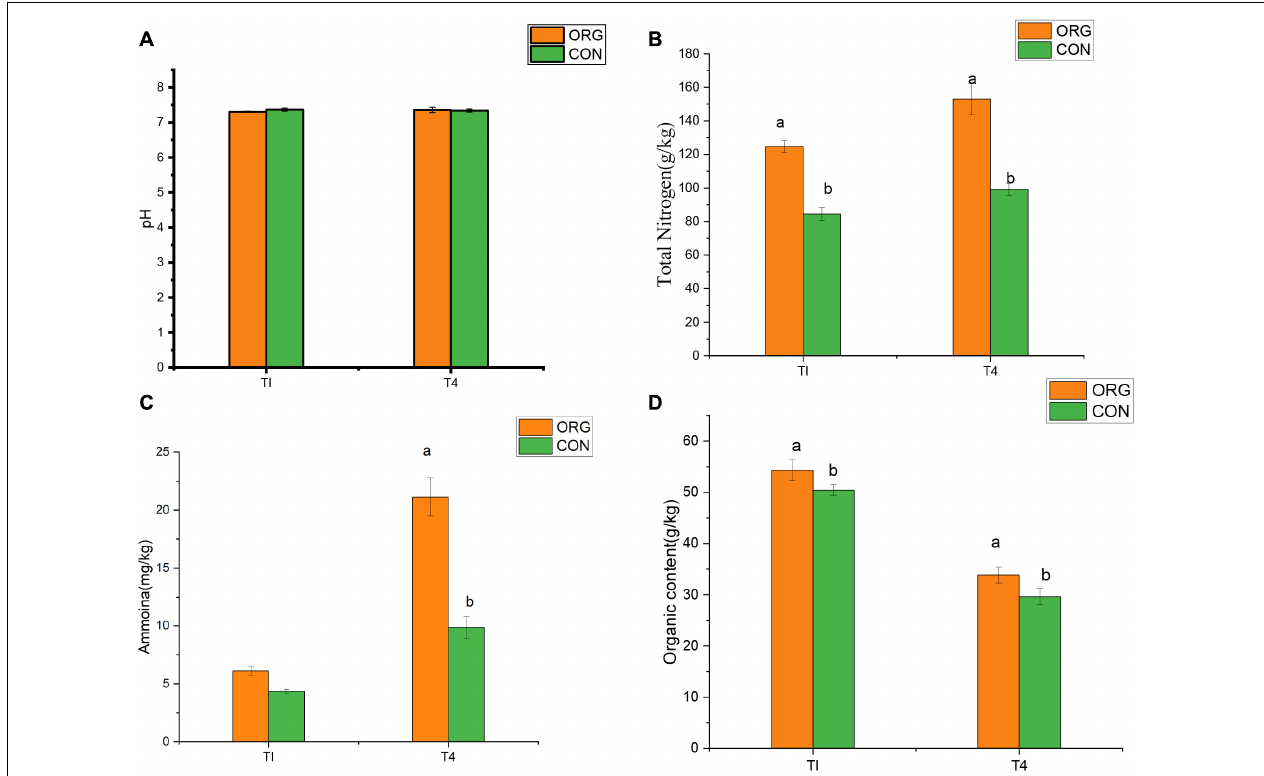
FIGURE 1 | Discrimination of physiochemical soil properties during the field experiment. (A–D) Differences in major physiochemical soil properties between seedling phase and fruiting phase (averaged over time). (A) pH, (B) total nitrogen, (C) ammonia content, and (D) organic content. Different letters denote dramatically significant ( p < 0.01). TI, seedling phase; T4, fruiting